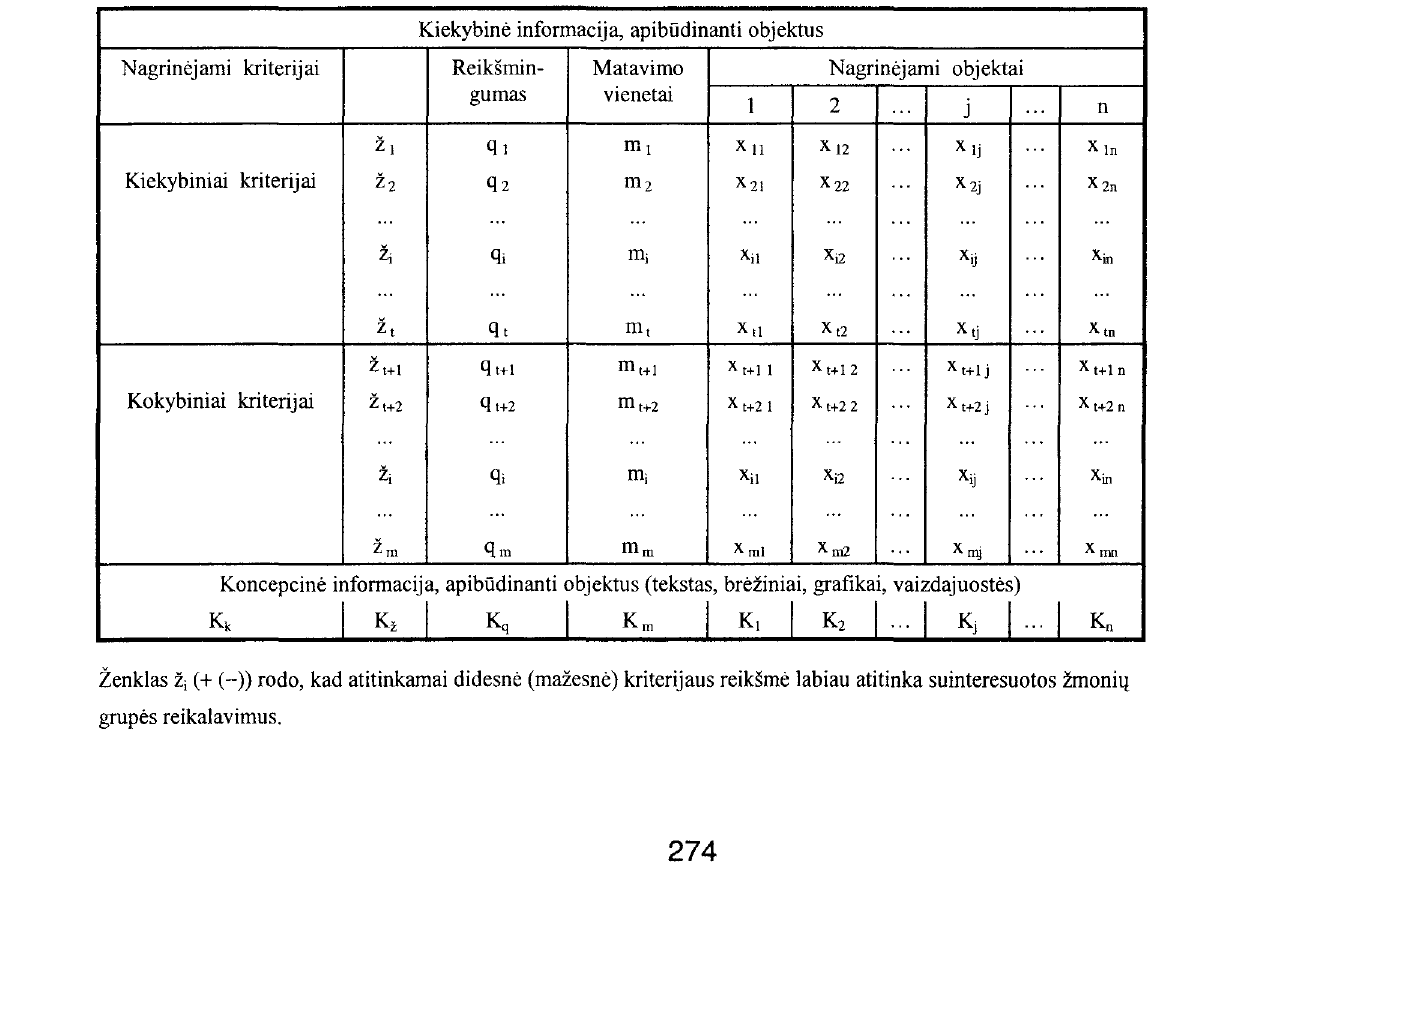
Table 1. A grouped decision-making matrix of multiple criteria analysis applied to the objects